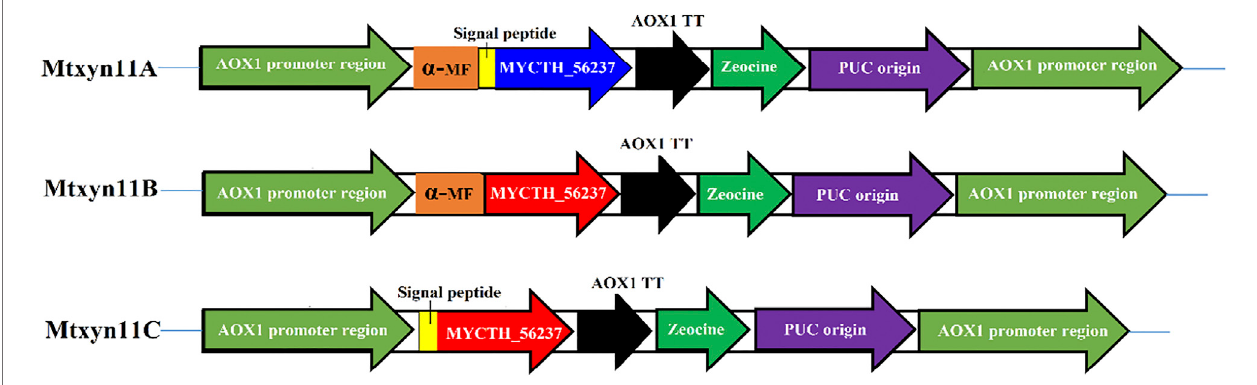
FIGURE1| Schematicrepresentationfortheconstructionofplasmid(pPICZ α A)havingdifferentsignalpeptides.Mtxyn11A:pPICZ α Acontainingbothnativesignal peptide and α -MF; Mtxyn11B: pPICZ α A without native signal peptide; Mtxyn11C: pPICZ α A without α